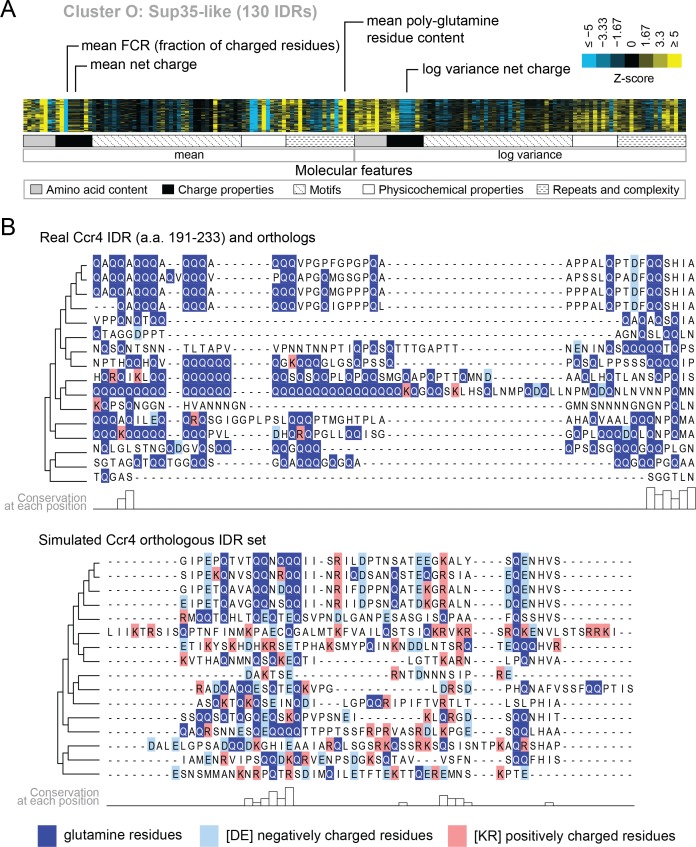
Evolutionary signatures in cluster O contain some molecular features that are typically associated with IDRs as well as some that are not.(A) Pattern of evolutionary signatures in cluster O. (B) Example disordered region from cluster O, Ccr4, with a subset of highlighted molecular features compared between its real set of orthologs and an example set of simulated orthologous IDRs. Species included in phylogeny in order from top to bottom are S. cerevisiae, Saccharomyces mikatae, Saccharomyces kudriavzevii, Saccharomyces uvarum, Candida glabrata, Kazachstania naganishii, Naumovozyma castellii, Naumovozyma dairenensis, Tetrapisispora blattae, Tetrapisispora phaffii, Vanderwaltozyma polyspora, Zygosaccharomyces rouxii, Torulaspora delbrueckii, Kluyveromyces lactis, Eremothecium (Ashbya) cymbalariae, Lachancea waltii.